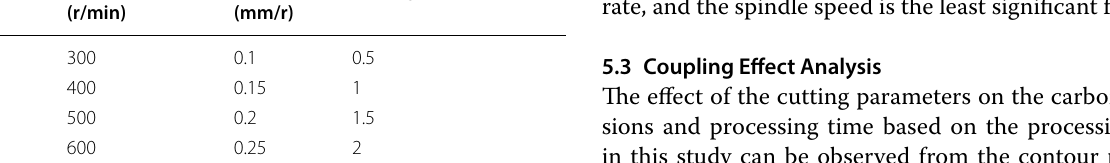
Table 4 Levels and factors selected for S/N ratios Spindle speed (r/min)